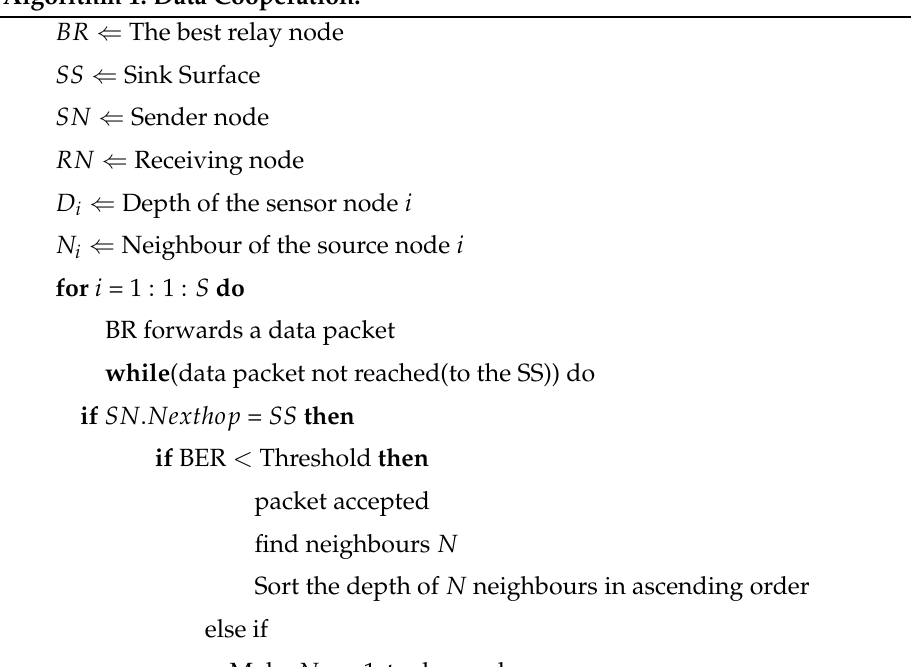
Algorithm 1: Data Cooperation. BR ⇐ The best relay